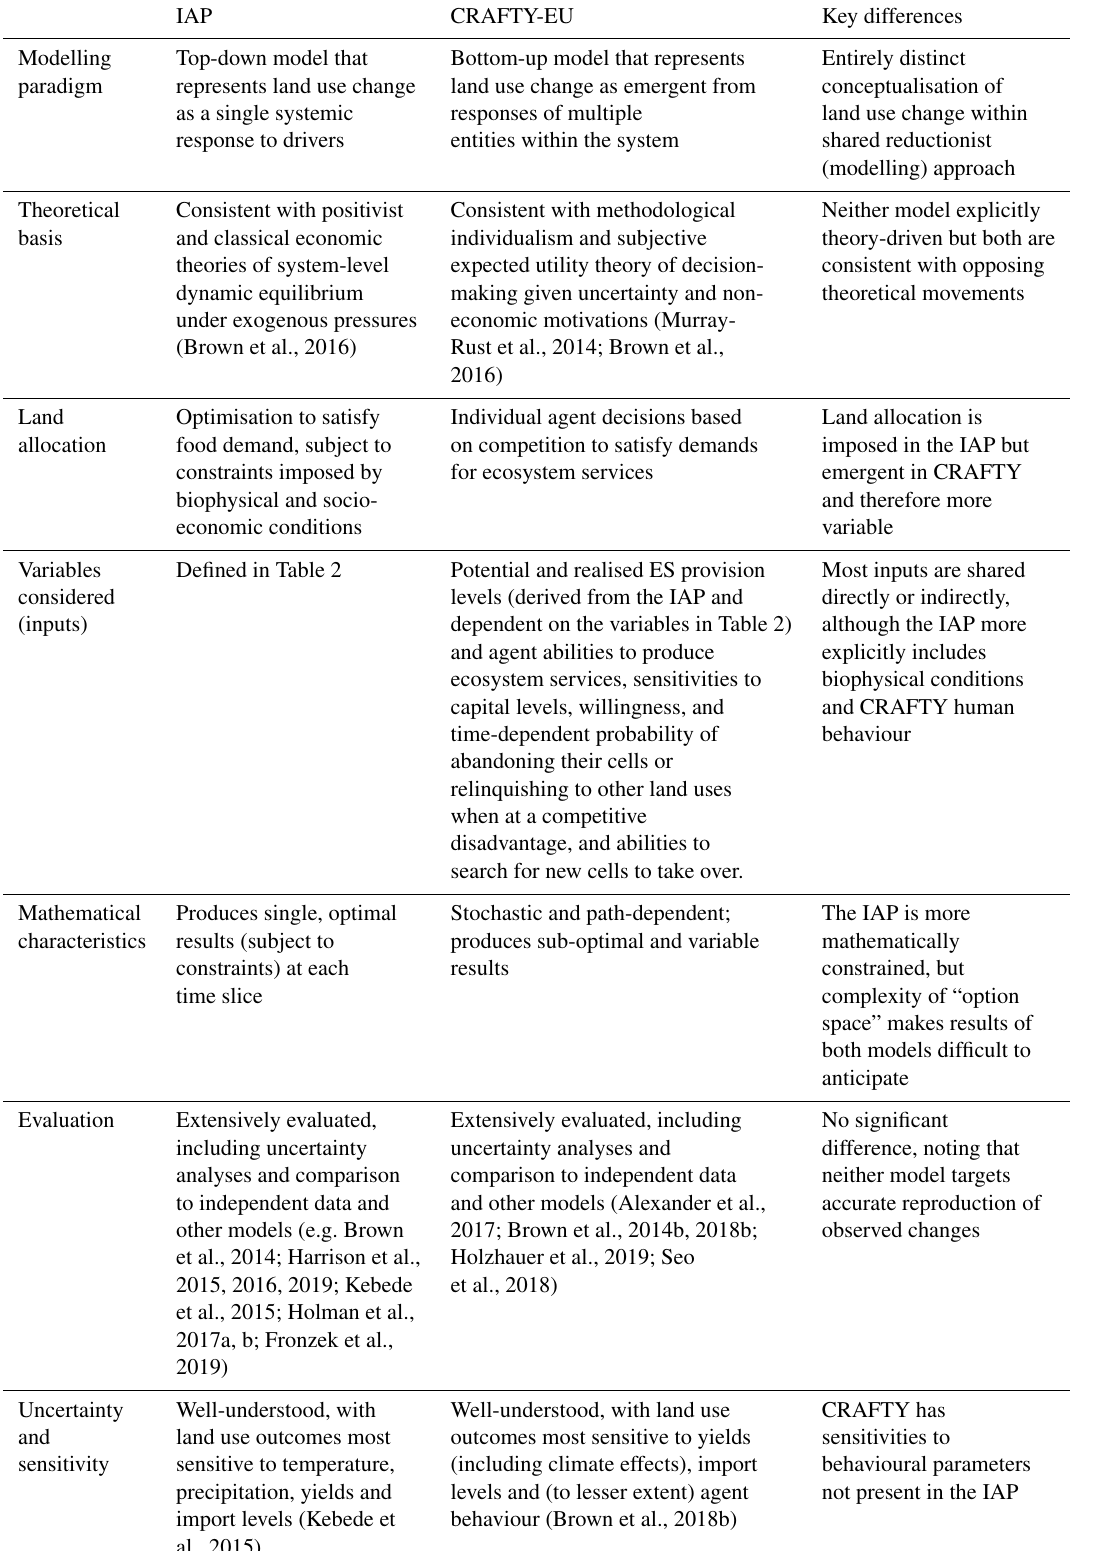
Table 3. Summary comparison of the two models used in this study across a range of characteristics, many of which stem from the distinct modelling paradigms used. Further details are provided in the text and the references cited